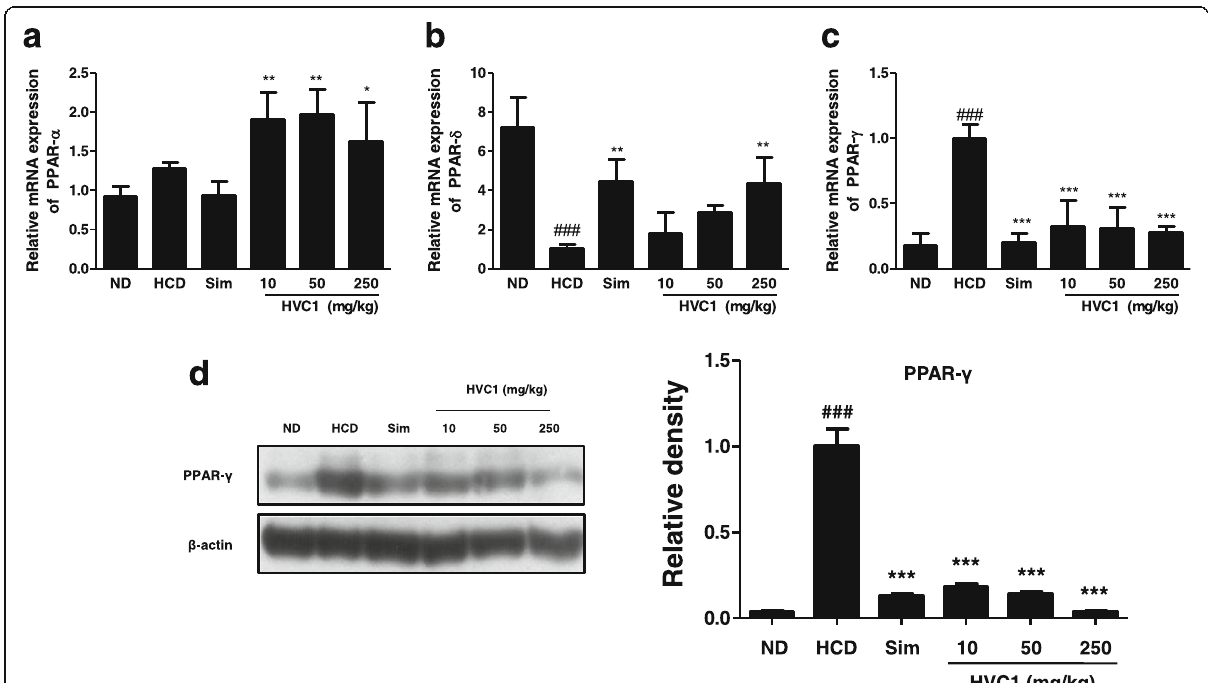
Fig. 3 Inhibitory effect of HVC1 on the HCD-induced PPARs expressions in LDLR − / − mice. LDLR − / − mice were randomized into the ND group, HCD group, and treatment groups fed HCD with simvastatin (10 mg/kg) or HVC1 (10, 50 or 250 mg/kg) for 13 weeks. mRNA levels of PPARs ( a - c ) were analyzed by real-time PCR analysis. Expressions of PPAR- γ protein was determined by western blot assay using specific anti-PPAR- γ antibody ( d ). β -actin was used as a loading control. Values represent mean ± S.D. of three independent experiments (significant as compared to HCD, * p < 0.05, ** p < 0.01, *** p < 0.001, significant as compared to ND, ### p <